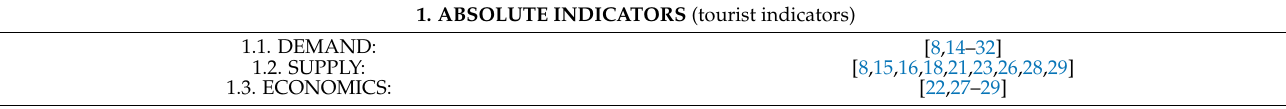
Table 1. Measuring overtourism through indicators: literature